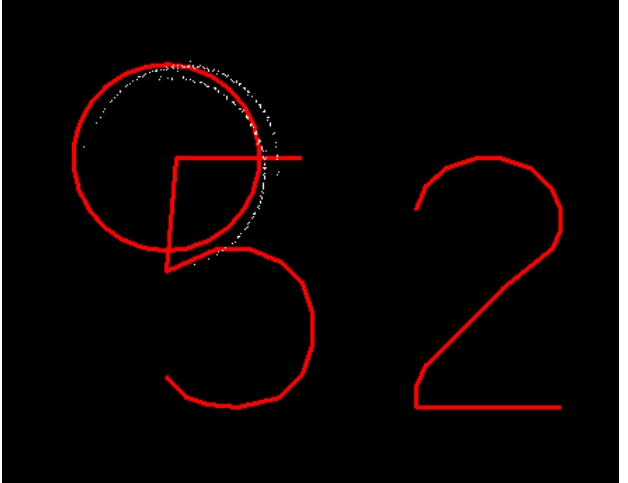
Figure 19. A large pole (reference target no. 52) seen double by a dual-scanner system (white